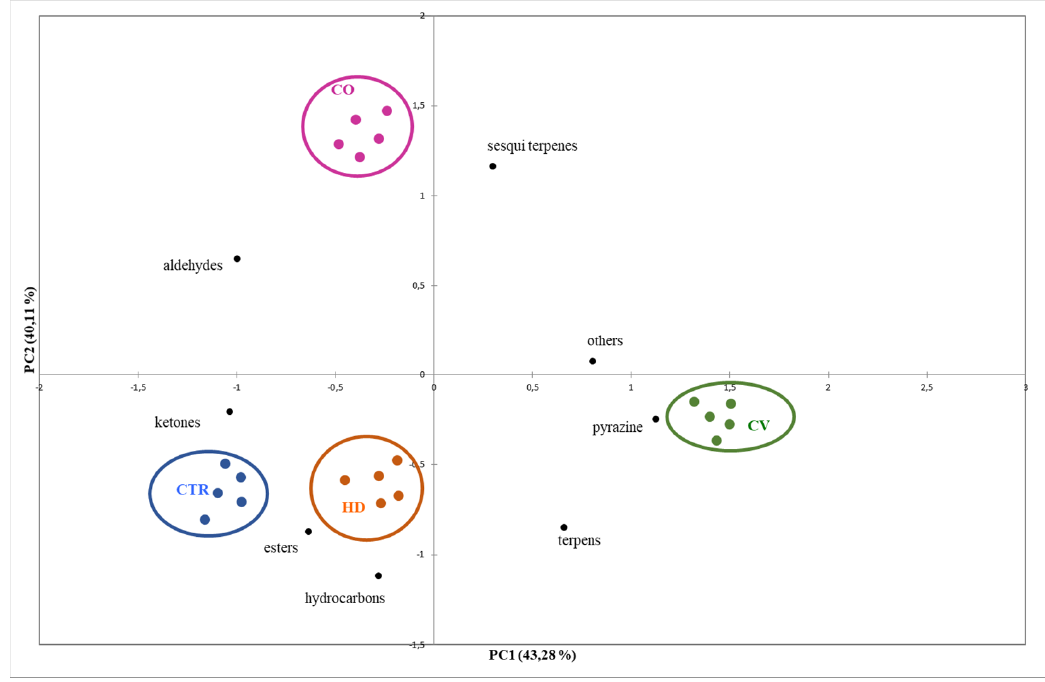
Figure 2. Bi-plots PCA (principal component analysis) of SPME-GC-QTOF/MS ( solid-phase micro-extraction coupled to gas chromatography separation and quadrupole time-of-flight mass spectrometry detection ) dataset.